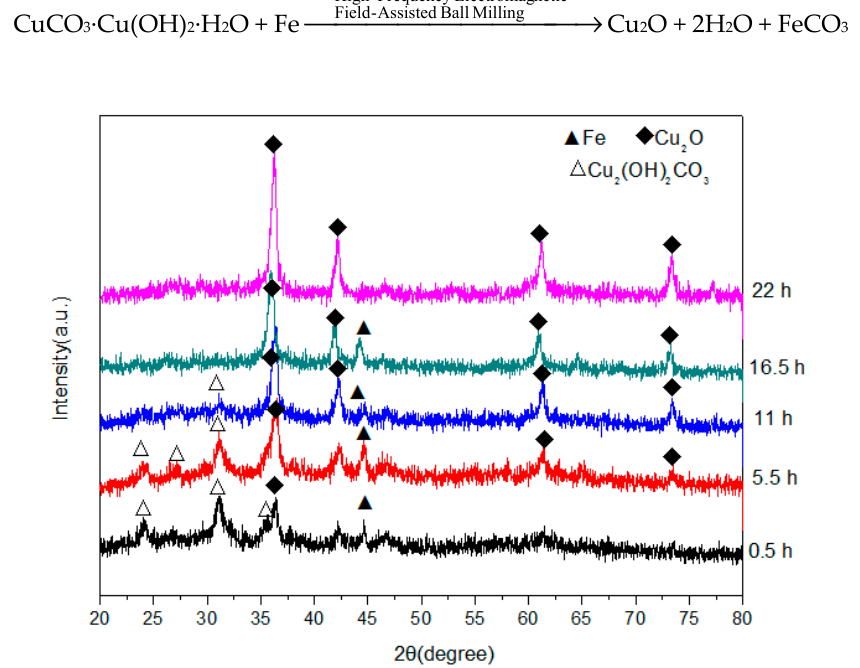
Figure 2. X-ray diffractometry (XRD) patterns of powders produced by high-frequency electromagnetic-field-assisted ball milling under aqueous conditions at different reaction times.